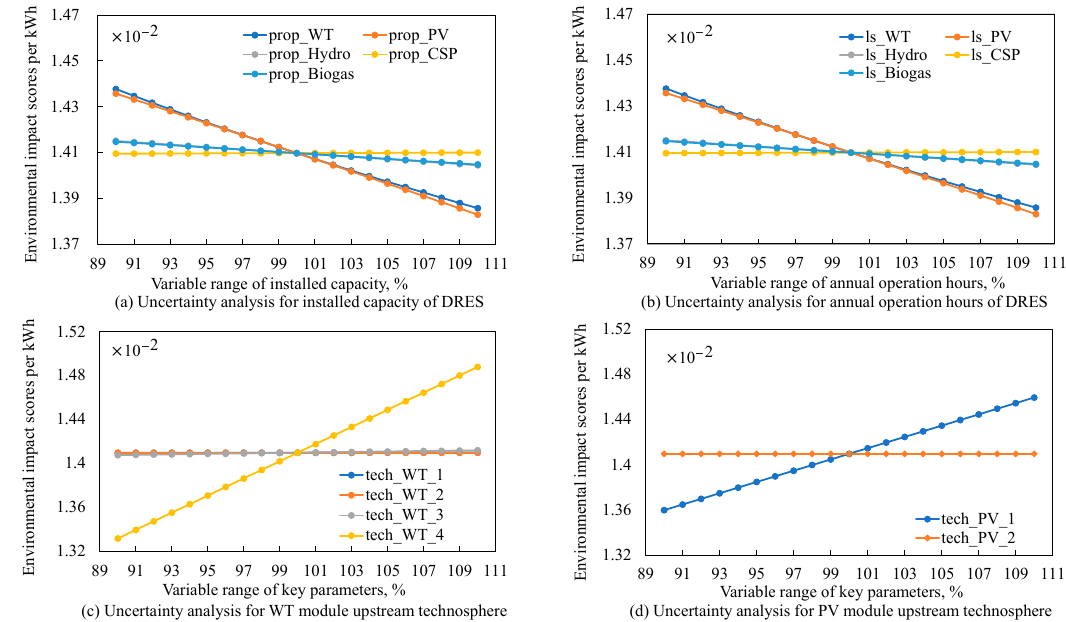
Figure 6. Uncertainty analysis results during the performance degradation process.